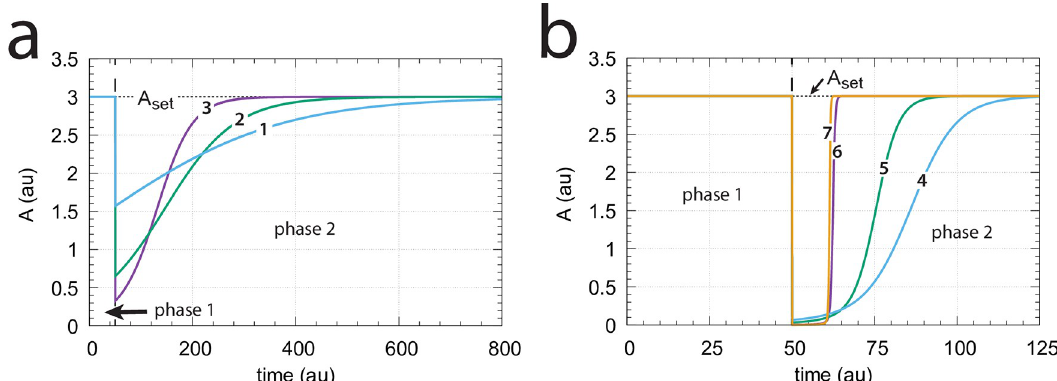
Fig 20. Response of the m4 random-order ternary-complex controller (Fig 19) with respect to step-wise changes in k 2 . (a) Phase 1: k 2 =10. At time t = 50 phase 2 starts with the following changes in k 2 : (1) k 2 =20, (2) k 2 =50, (3) k 2 =100. (b) Phase 1: k 2 =10. At time t = 50 phase 2 starts with the following changes in k 2 : (4) k 2 =500, (5) k 2 =1 × 10 3 , (6) k 2 =1 × 10 4 , (7) k 2 =2 × 10 4 . Other rate constants: k 1 =0.0, k 3 =1 × 10 5 , k 4 =1.0, k 5 =31.0, k 6 =1.0, k 7 =1 × 10 8 , k 8 =0.1, k 9 = k 11 = k 13 = k 15 =1 × 10 8 , k 10 = k 12 = k 14 = k 16 =1 × 10 3 , k 17 =0.1. Initial concentrations: A 0 =3.0, E 1,0 =1.0 × 10 − 2 , E 2,0 =3.0 × 10 2 , Ez 0 =3.3 × 10 − 11 , (E 1 � Ez) 0 =1.4 × 10 − 15 , (E 1 � Ez � E 2 ) 0 =1.0 × 10 − 8 , (EzE 2 ) 0 =9.9 × 10 − 7 . Total enzyme concentration Ez tot =1.0 × 10 − 6